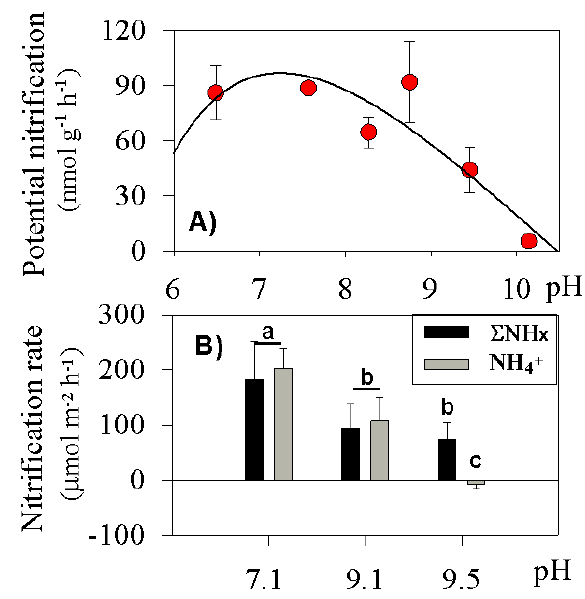
Figure 4. Experimental pH effects on total ammonium flux rates (A) and nitrate flux rates (B). Sediment cores were taken from Powerline (PL) and Budds Landing (BL). Data are presented as mean flux rates ± standard error. At each site, different letters are used to show significant difference (Tukey test, P ≤ 0.05).